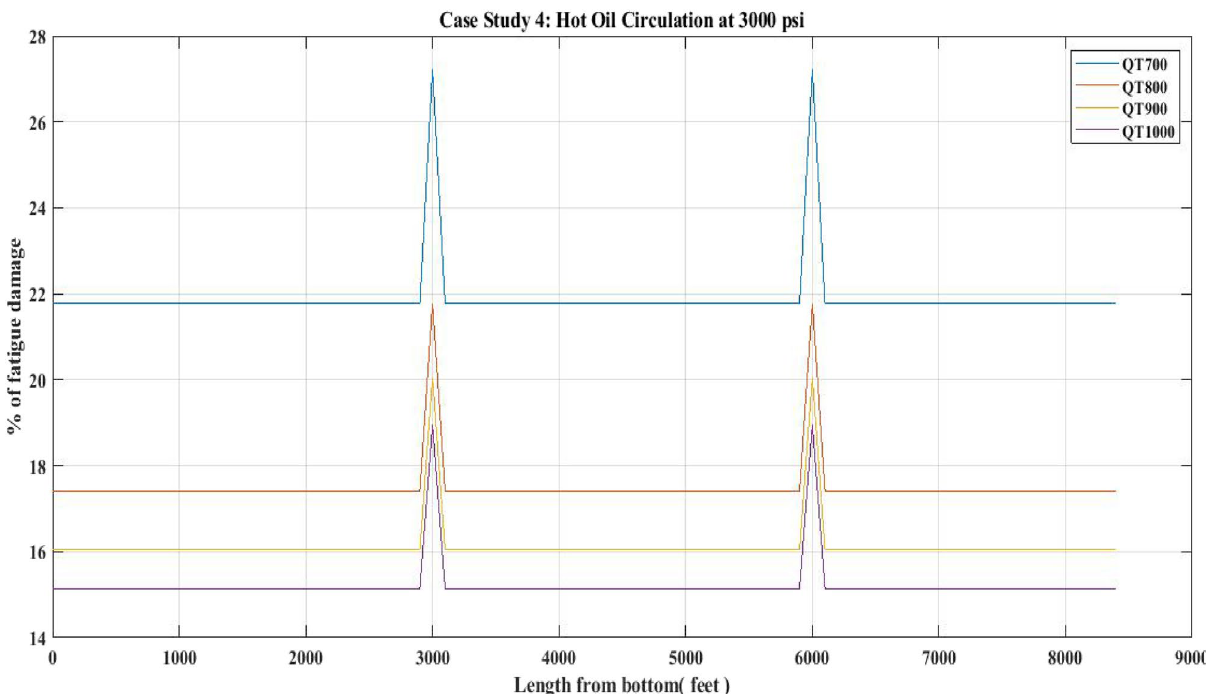
Figure 28. Percentage of fatigue damage with respect to hot oil circulation at 3000 psi pressure.